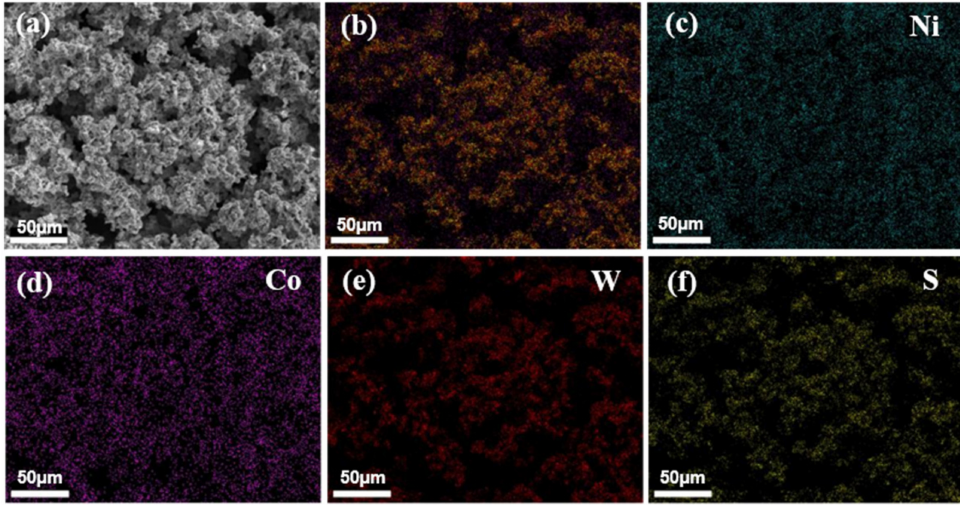
Figure 3. ( a , b ) SEM image of the Ni-Co/WS 2 nanocomposite coating and the corresponding EDS mappings of ( c ) Ni, ( d ) Co, ( e ) W, and ( f )